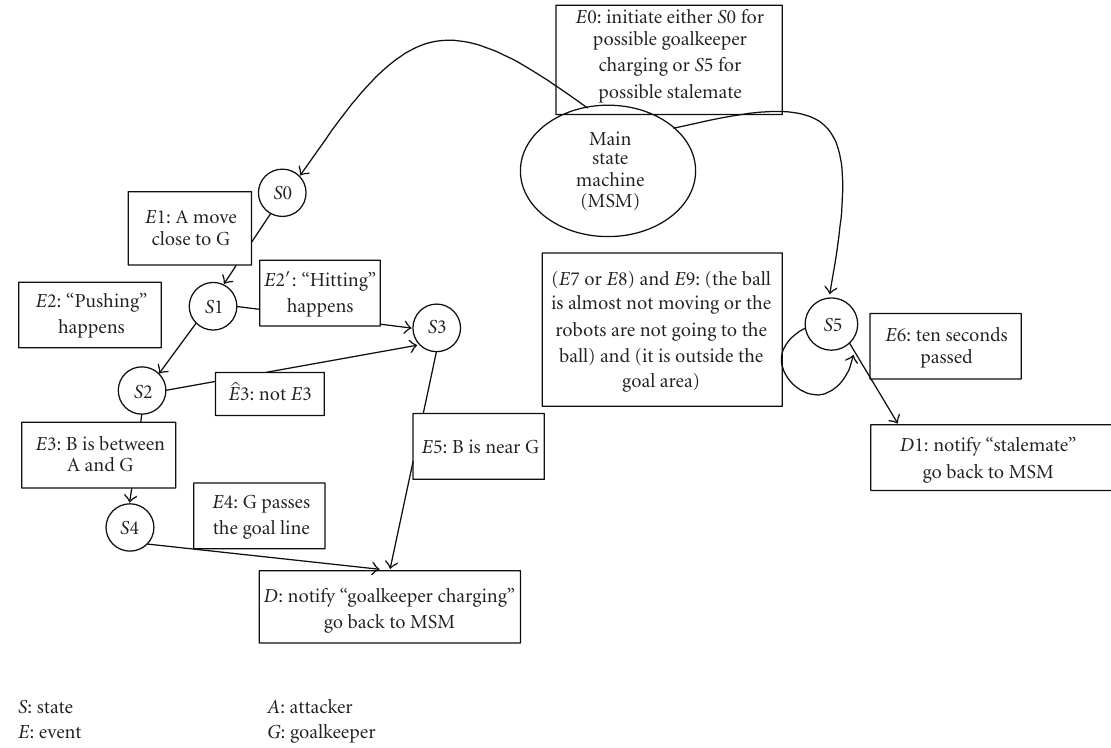
Figure 5: Sample architecture of finite state machines for detecting goalkeeper charging and stalemate.